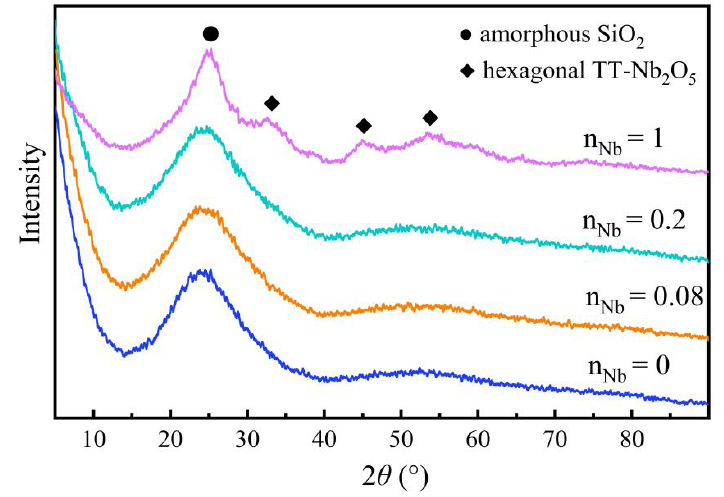
SiO 2 frameworks.